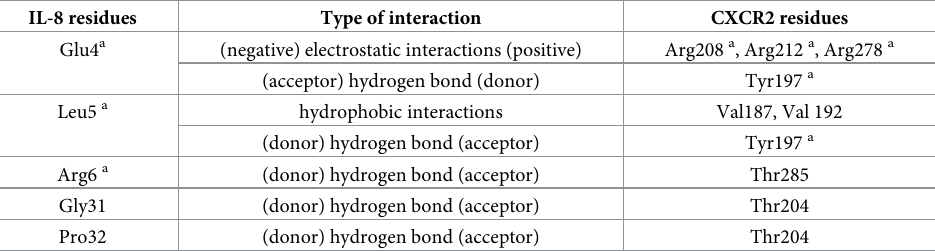
Table 1. Interactions between the residues of IL-8 and the corresponding residues of CXCR2 receptor in the active site 2. IL-8